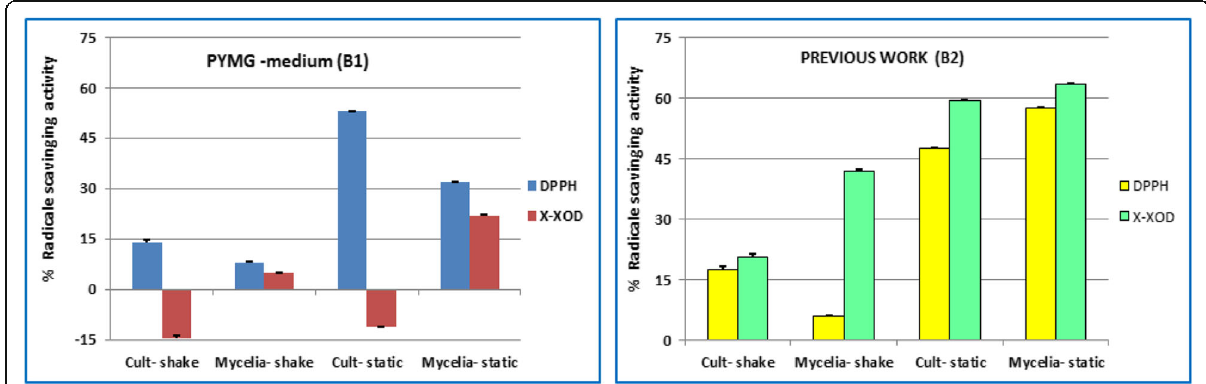
Fig. 4 Demonstrative antioxidant comparison between PYMG medium (5% glucose, distilled water) and previous work medium (10% glucose,